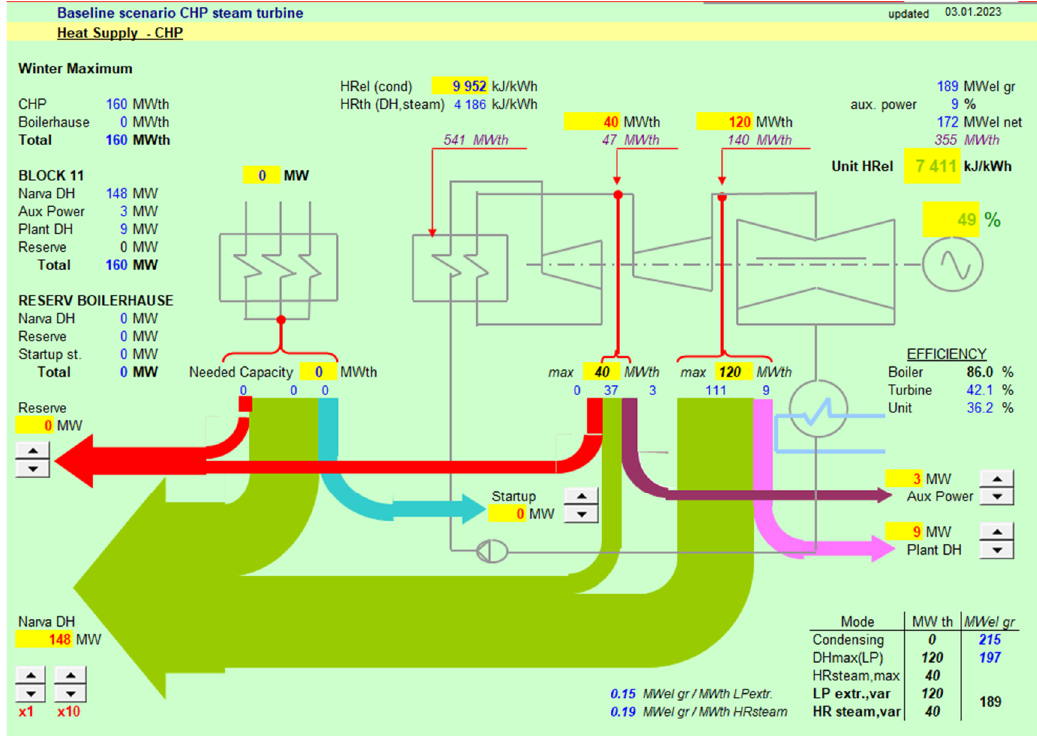
Figure 1. Simplified process flow diagram of the CHP extraction steam turbine in the baseline scenario.